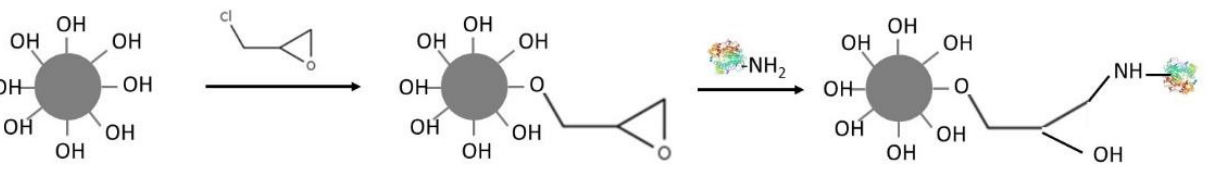
adsorption and Fe 3 O 4 @MCM-41/APTS for PPL cross-linking with GA.